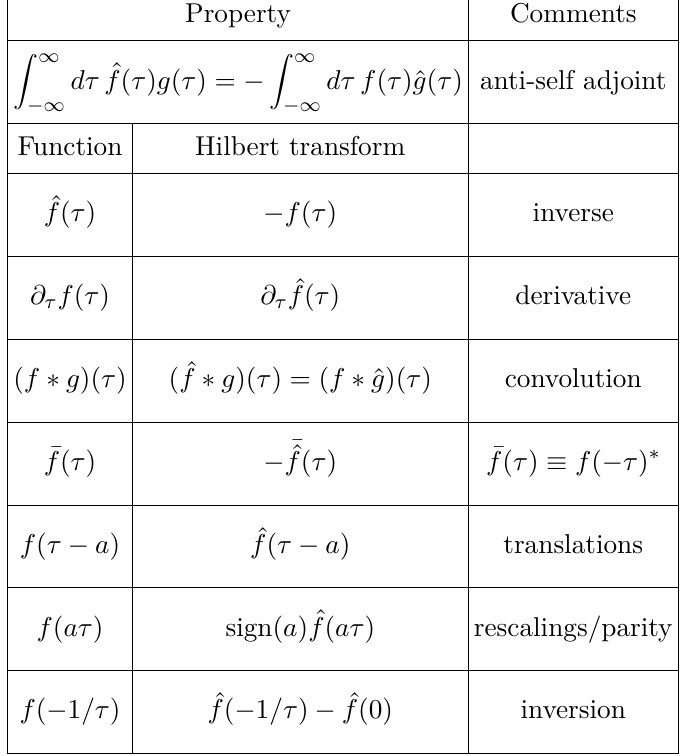
Table 2 . Useful Hilbert transform